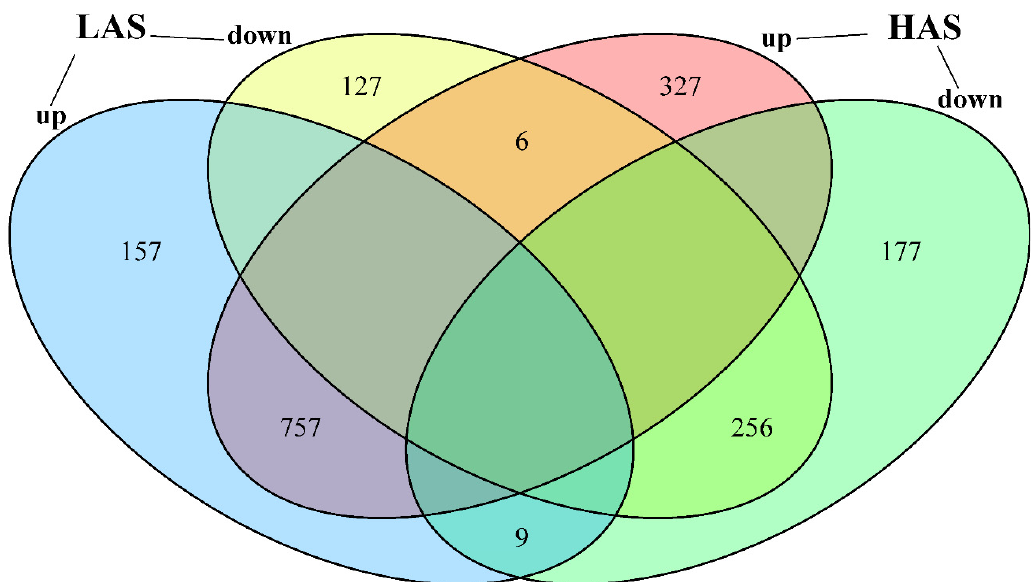
Figure 2. Venn diagram showing the enriched genes (upregulated and downregulated) in M. cerifera after low-concentration alkali stress (LAS) and high-concentration alkali stress (HAS) treatments, compared with the control with a p value of <0.05.